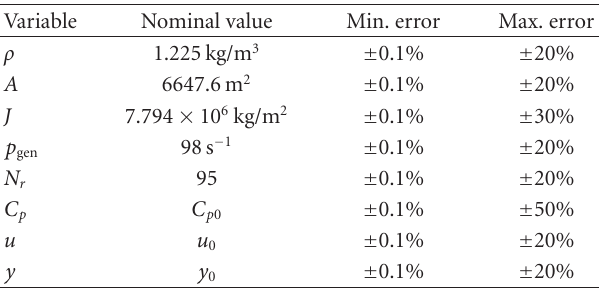
Table 3: Simulated wind turbine parameter uncertainties.